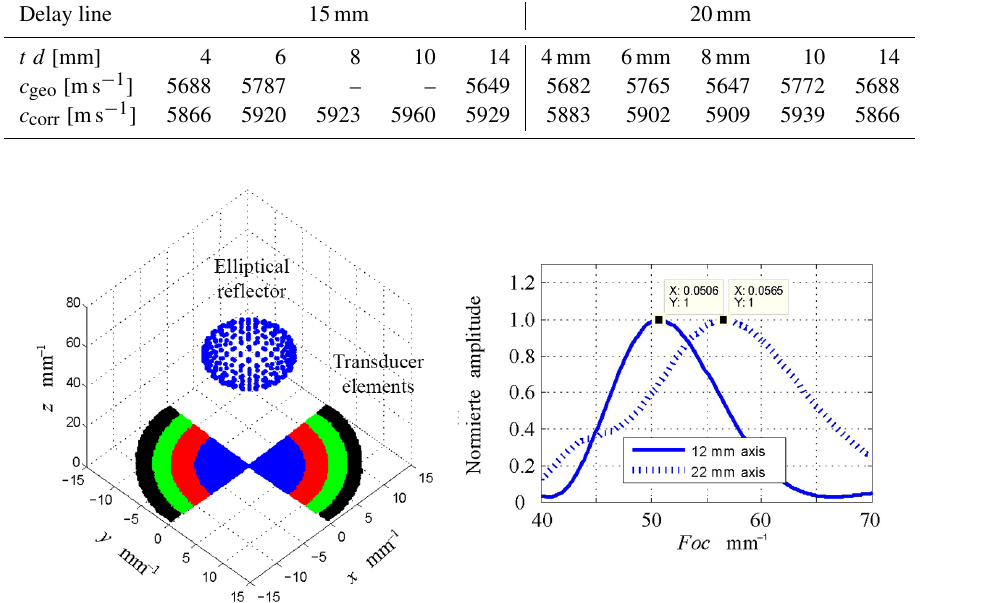
(Fig. 9, left), the ToF from the innermost element to the outer element with number four depends on the reflector radius (Fig. 9, right). Under the given conditions, sphere radii could be determined with an uncertainty of about 0.5 mm, where spheres of between 6 and 11 mm radius were used in the ex- periments (Lenz,